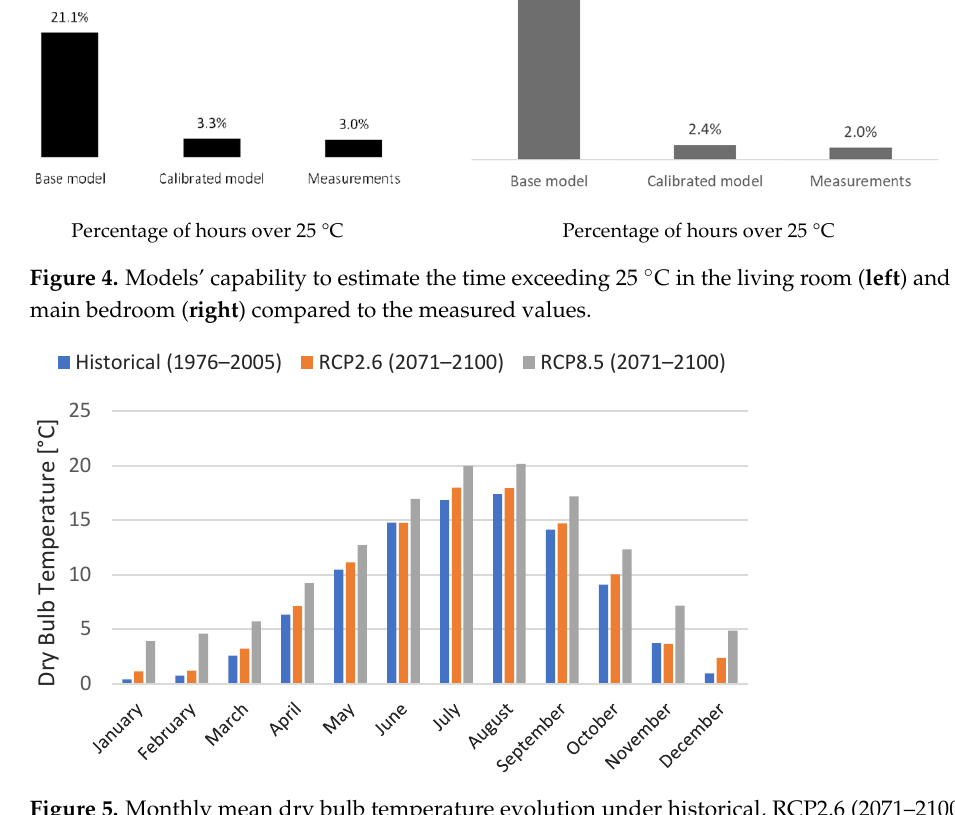
Figure 5. Monthly mean dry bulb temperature evolution under historical, RCP2.6 (2071–2100) and RCP8.5 (2071 – 2011) scenarios according to ALARO Model [29].